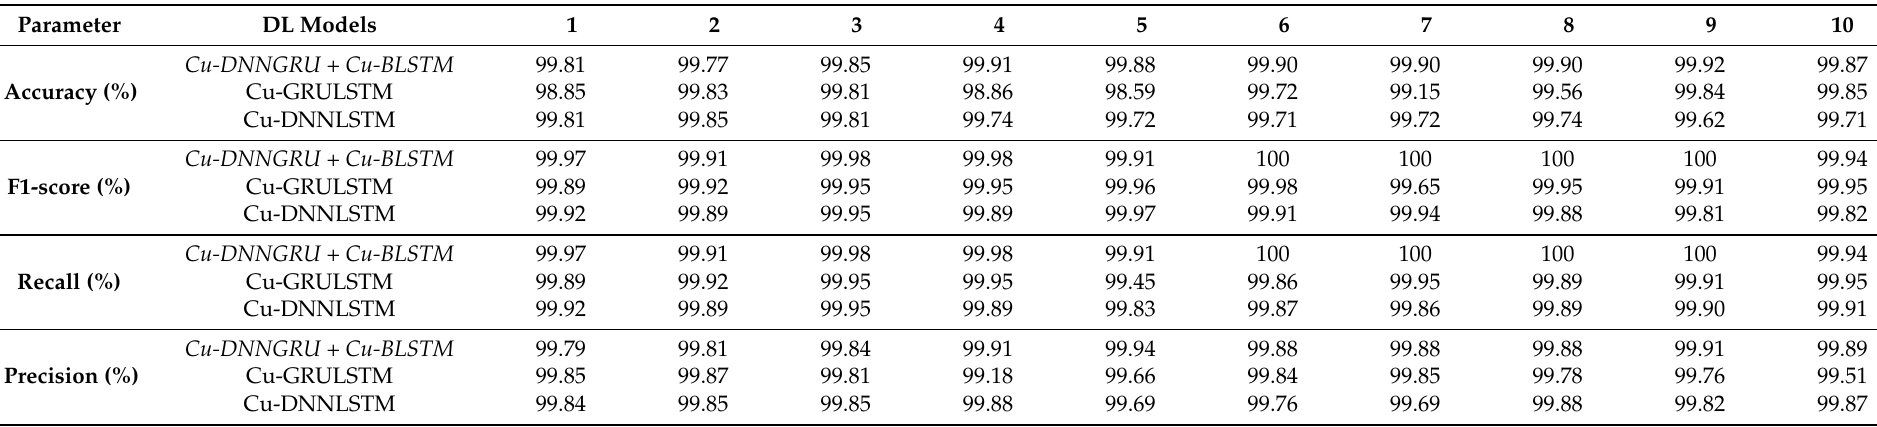
Table 5. 10-folds cross validation results.